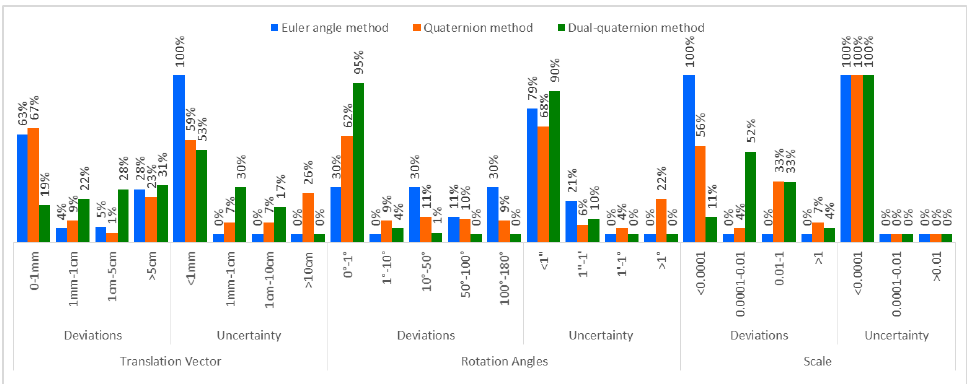
Figure 12. Histograms of deviations and uncertainty in the testing scenarios for all Helmert transformation parameters.